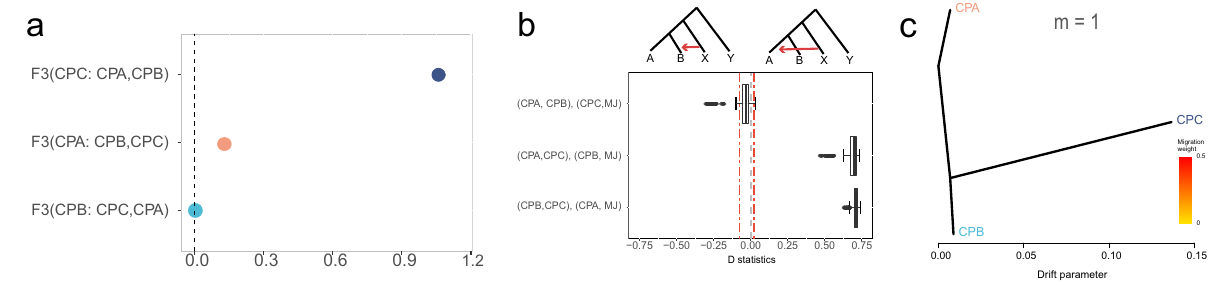
Fig. 2 Genetic differentiation and gene fl ow analysis among Chinese pangolins. a F3 statistics for CPA, CPB and CPC. b D-statistics: A, B, X were among each of three Chinese pangolin populations and the Malayan pangolin (MJ) was set as the outgroup (Y). The red dashed lines represent the threshold value of D that is signi fi cantly deviating from 0. c TreeMix trees with no migration events (m = populations was admixed by the other two populations with positive scores in each combination (Fig. 2a).